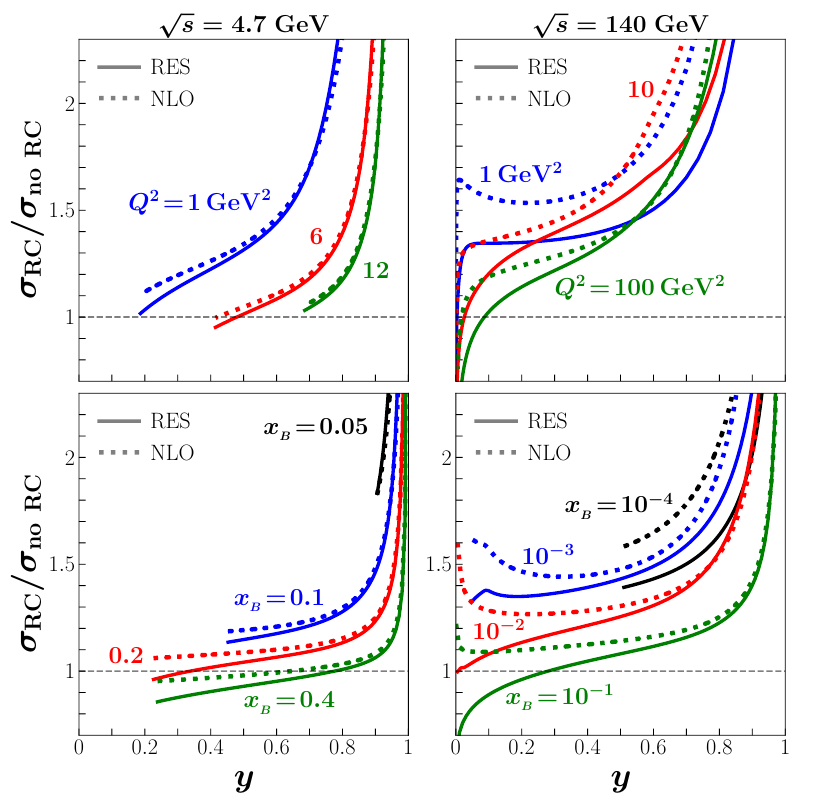
Figure 8 . Ratio of inclusive ep cross sections with QED radiation effects ( σ RC ) to those without radiation ( σ noRC ) versus y at fixed values of Q 2 (top row) and fixed x √ Lab energy s = 4 . 7 GeV (left) , and EIC energy solid lines) and fixed-order (“NLO”, dashed lines)